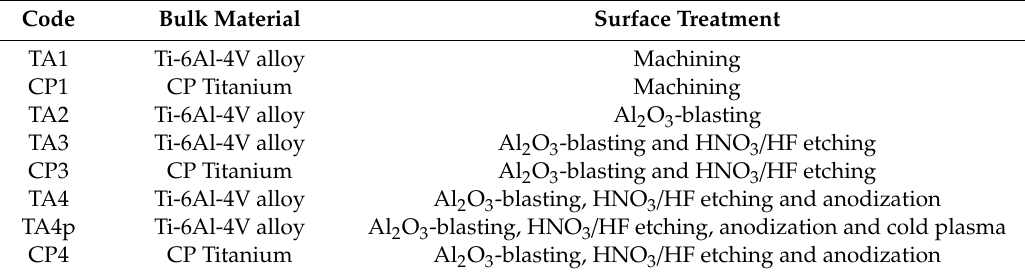
Table 2. List of analyzed samples and respective identification codes.